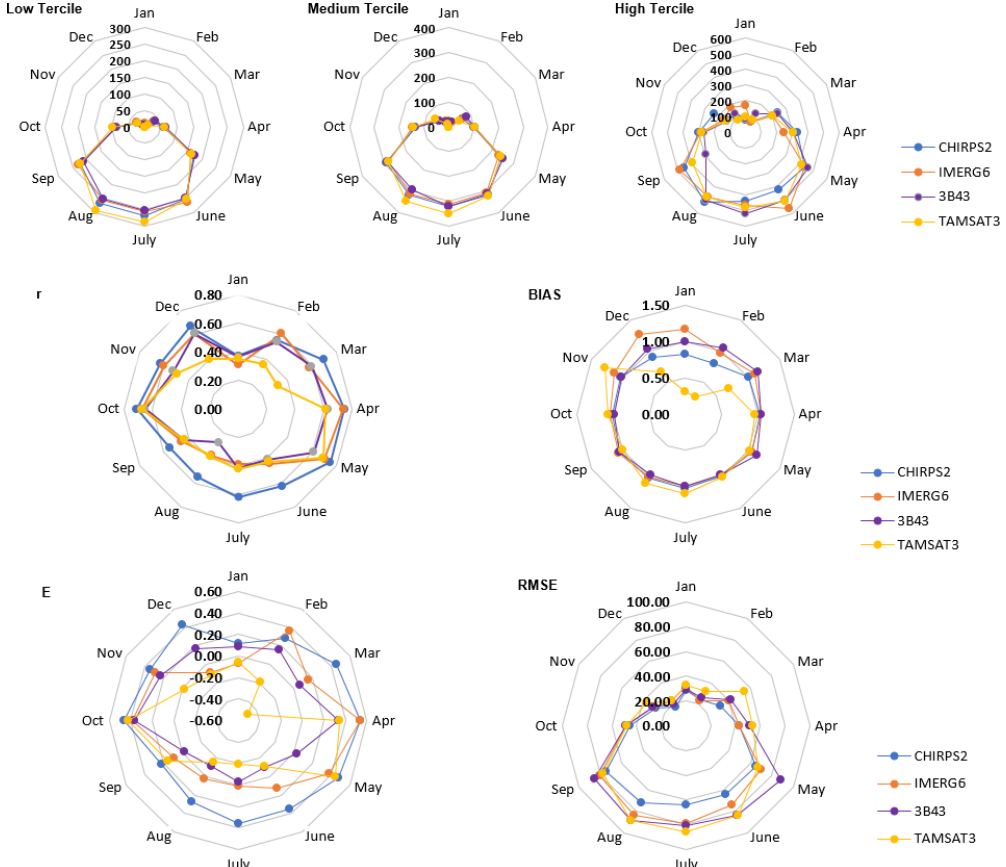
Figure 7. Seasonal statistical evaluation result comparison of each SRE for the DRB. Table 5. Calibration and validation results for the different rainfall products. Rainfall products Calibration Validation NSE